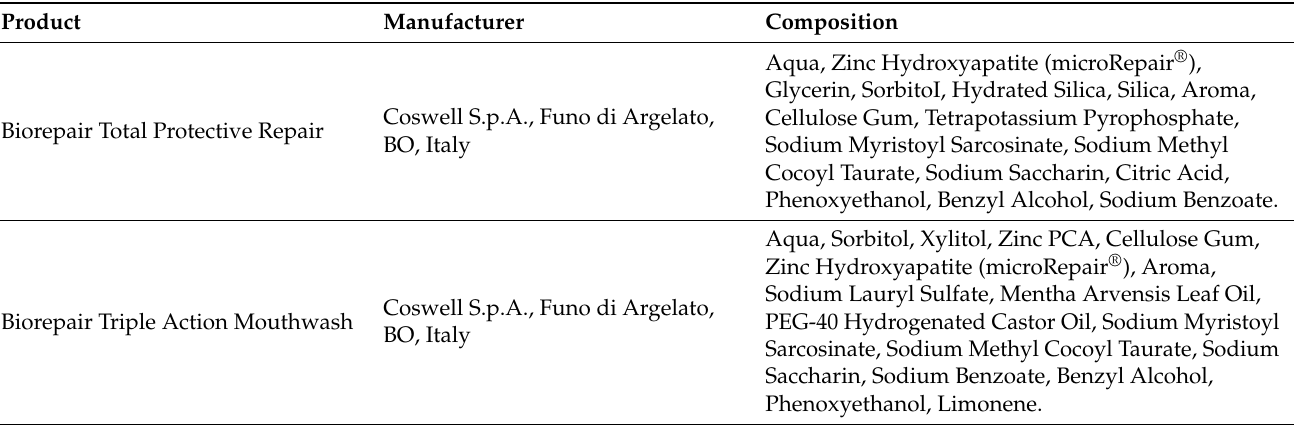
Table 1. Materials used in the study and their